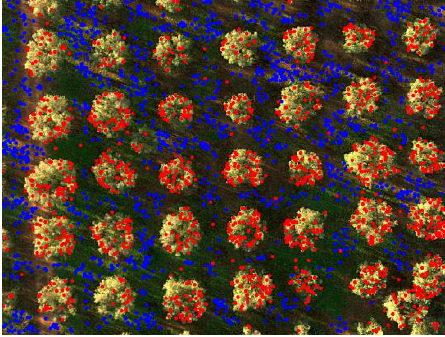
Figure 10. Points of the 3D cloud subdivided between (blue) ground and (red) tree crowns.